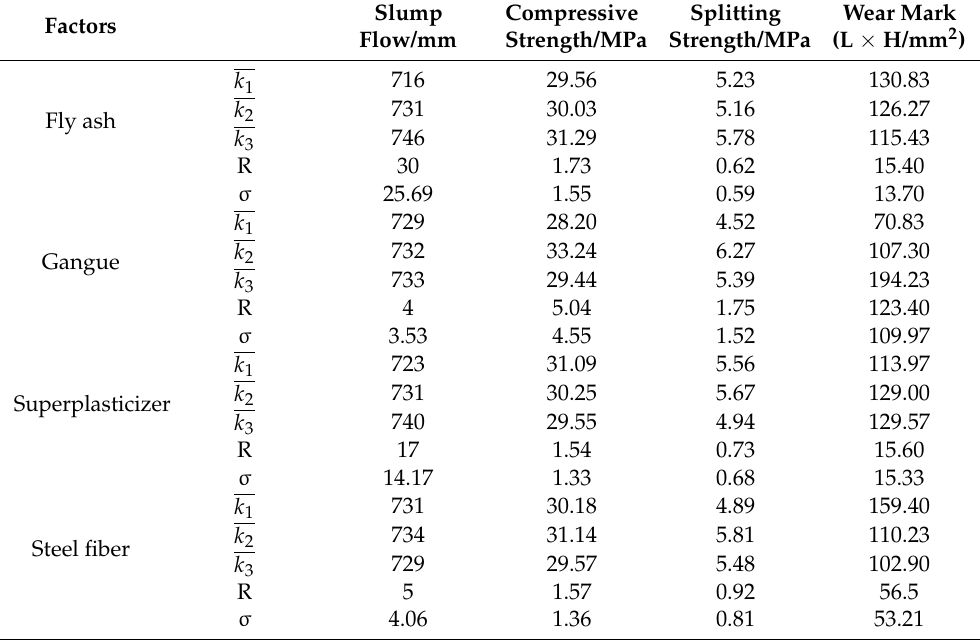
Table 9. Range and standard deviation